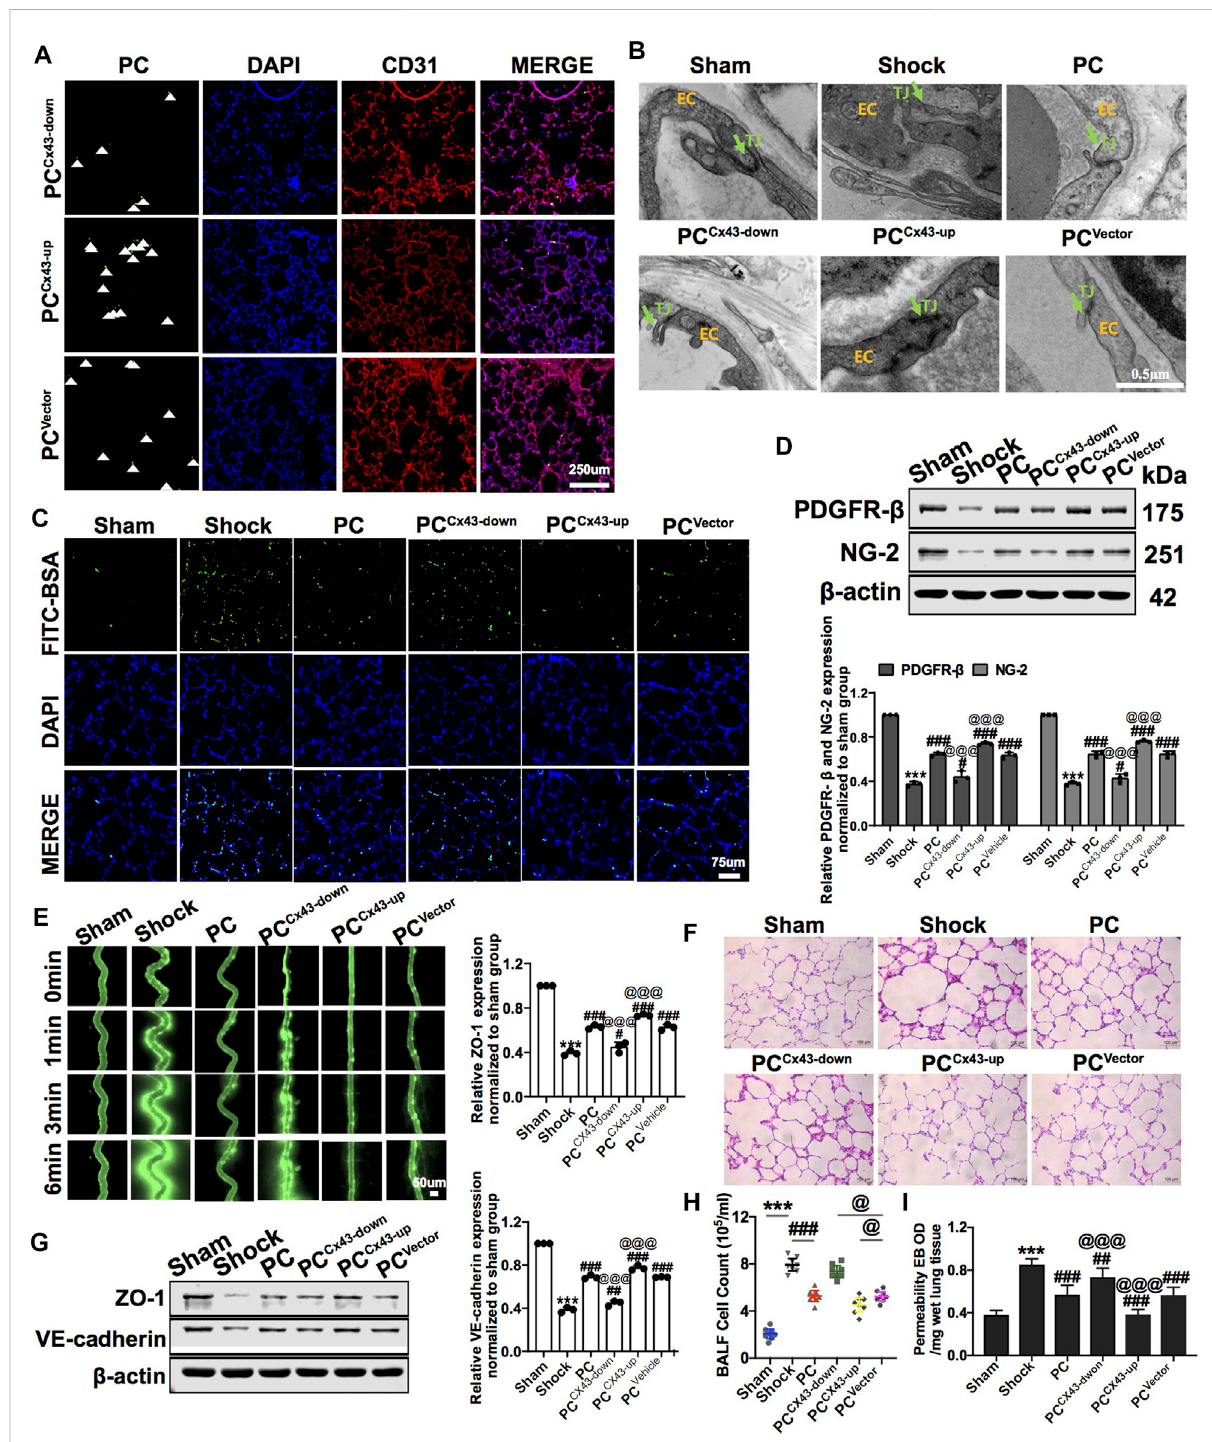
FIGURE 5 Effect of regulating Cx43 expression in PCs on the colonization of PCs and vascular permeability following hemorrhagic shock. (A) Cx43 up- and downregulationinGFP-PCscolonizedonthepulmonaryveins( n =8). (B) TightjunctionstructureofVECsobservedbyTEM( n =32pulmonaryveinsfromeight rats). (C) Changes of the pulmonary vascular permeability determined by FITC-BSA ( n = 8). (D) Protein expression of PDGFR- β and NG-2 in pulmonary veins determined by WB ( n = 12 pulmonary veins from three rats). (E) Mesenteric microvessel permeability determined by FITC-BSA ( n = 8 mesenteric microvesselsfromeightrats). (F) Changesofthein fi ltrationofin fl ammatorycellsinthealveolarspaceaftertreatment( n =8). (G) ProteinexpressionofZO-1and VE-cadherininpulmonaryveinsdeterminedbyWB( n =12pulmonaryveinsfromthreerats). (H) ChangesoftheamountofcellinBALFaftertreatment( n =8).